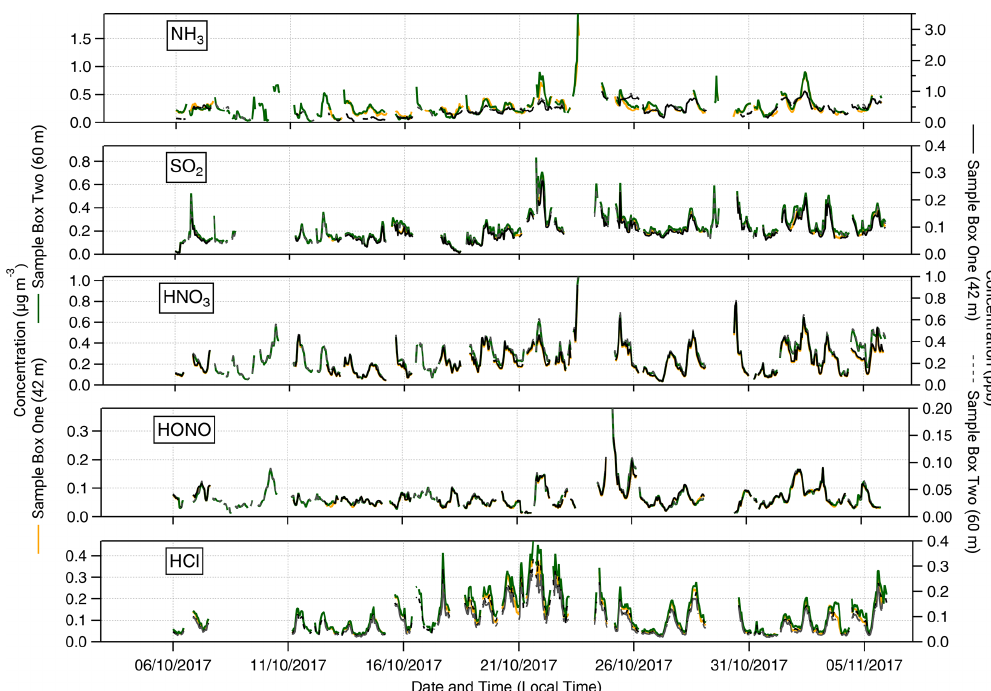
Figure 2. Time series of hourly concentrations (primary left axis, mass concentrations; secondary right axis, molar mixing ratios) of inorganic trace gas species measured by GRAEGOR at 42m (yellow, mass concentration; solid black line, molar mixing ratio) and 60m (green, mass concentration; dashed grey line, molar mixing ratio) on the 80m tower at the Amazon Tall Tower Observatory